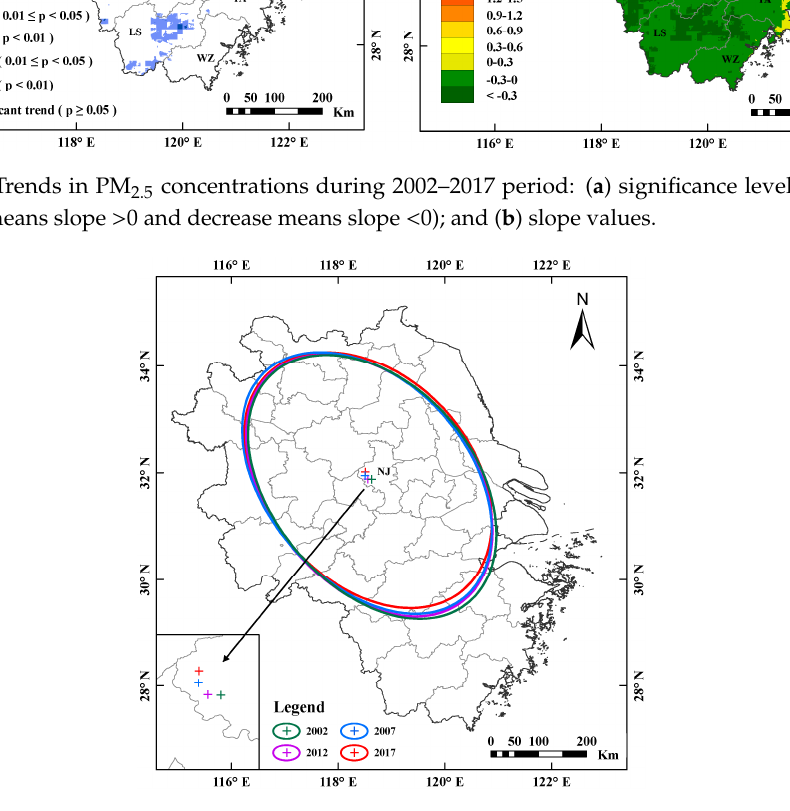
Figure 4. Standard deviational ellipses of PM 2.5 pollution in 2002, 2007, 2012 and 2017. The cross marks denote the median centers of the ellipses. Table 2. Median centers, long-short axis ratios and azimuths of the standard deviational ellipses in 2002, 2007, 2012 and 2017.